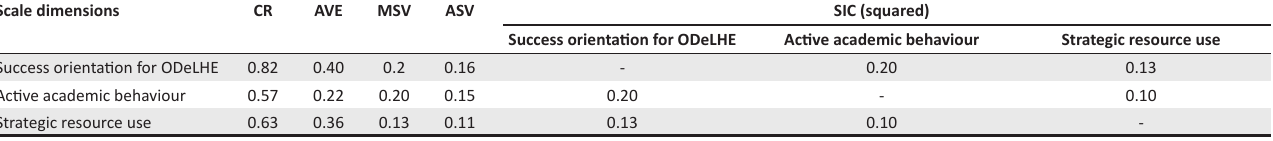
Scale dimensions Success orientation for ODeLHE